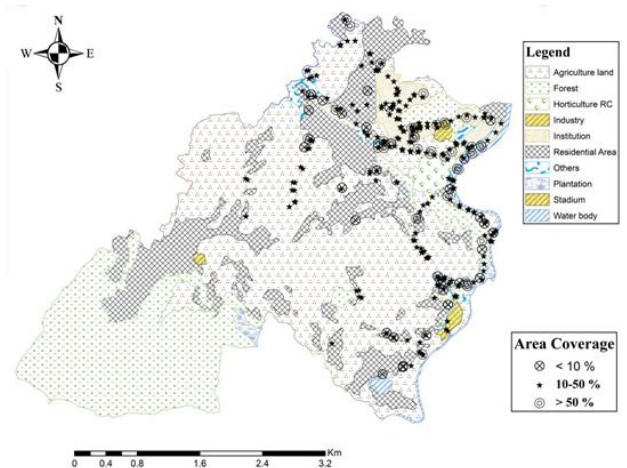
Fig. 3: Spatial distribution of Parthenium in Kirtipur Municipality